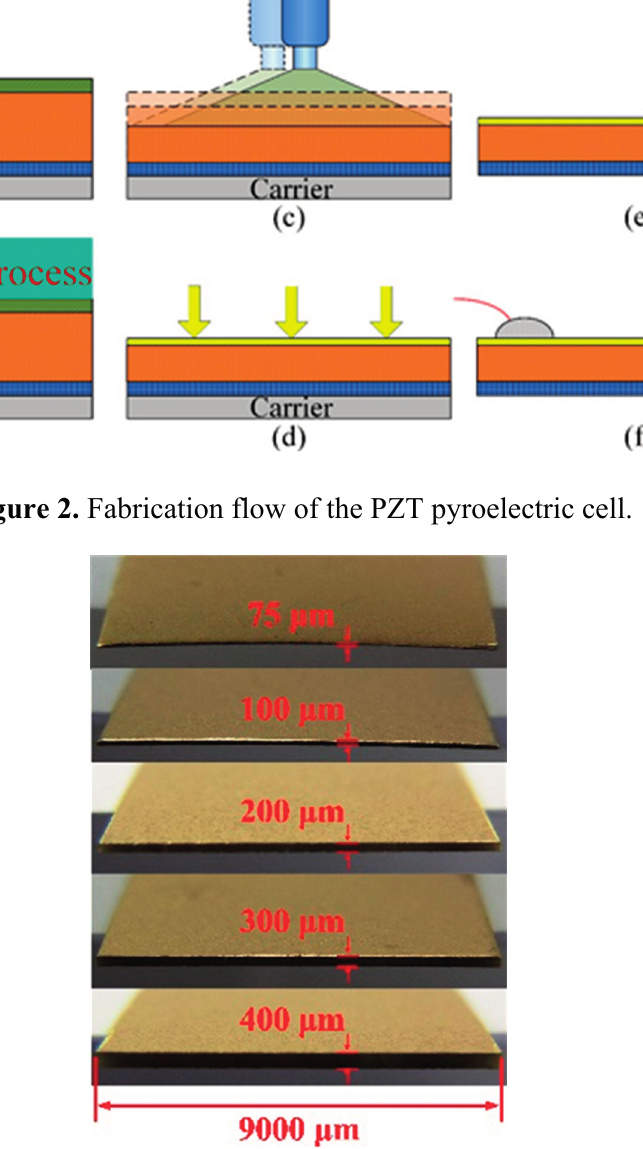
Figure 3 . Fabricated pyroelectric cells with various